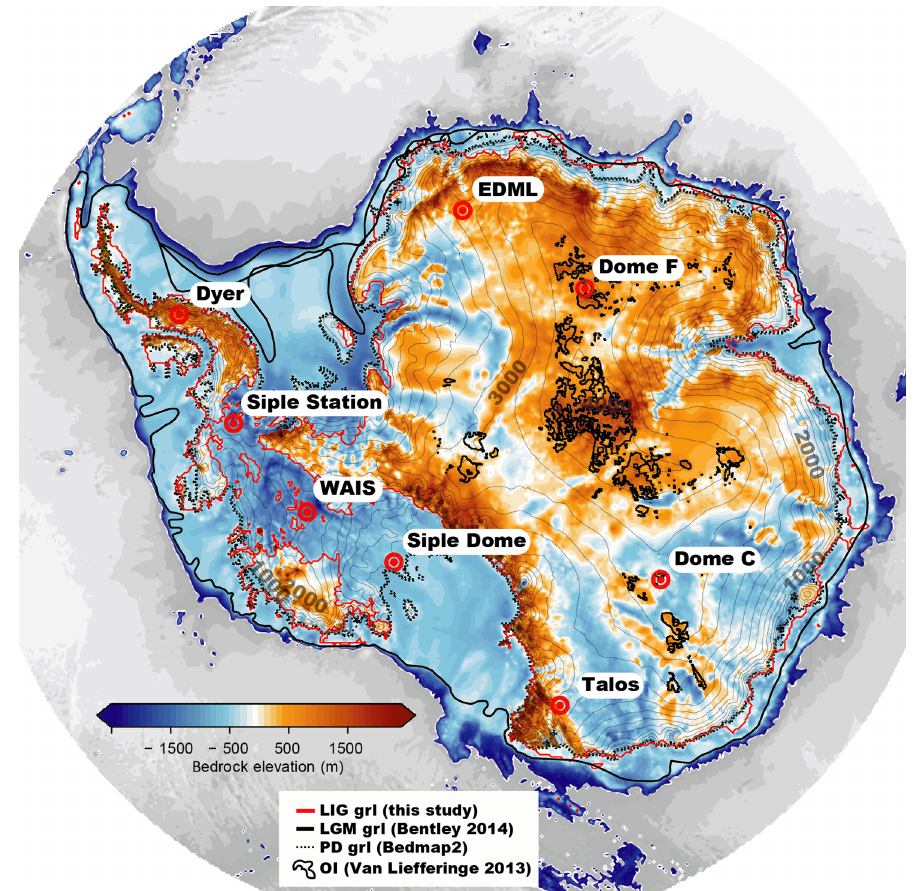
Figure 1. Antarctic bedrock topography overlain by surface contours (grey lines). The present-day (PD) grounding line (grl) from BEDMAP2 (Fretwell et al., 2013) depicted by the dashed black line. The Last Glacial Maximum (LGM) grounding line reconstruction from Bentley et al. (2014) (thick black lines) is compared to simulated grounding line retreat in one of the ensemble members for the Last Interglacial (LIG, red line). Regions previously identified as potentially viable sites for Oldest Ice (Van Liefferinge and Pattyn, 2013) are outlined by thick black lines. Eight ice core locations are highlighted, which are used as tuning targets with respect to ice core thickness and analysed in Figs. 9 (West Antarctica) and 10 (East Antarctica),